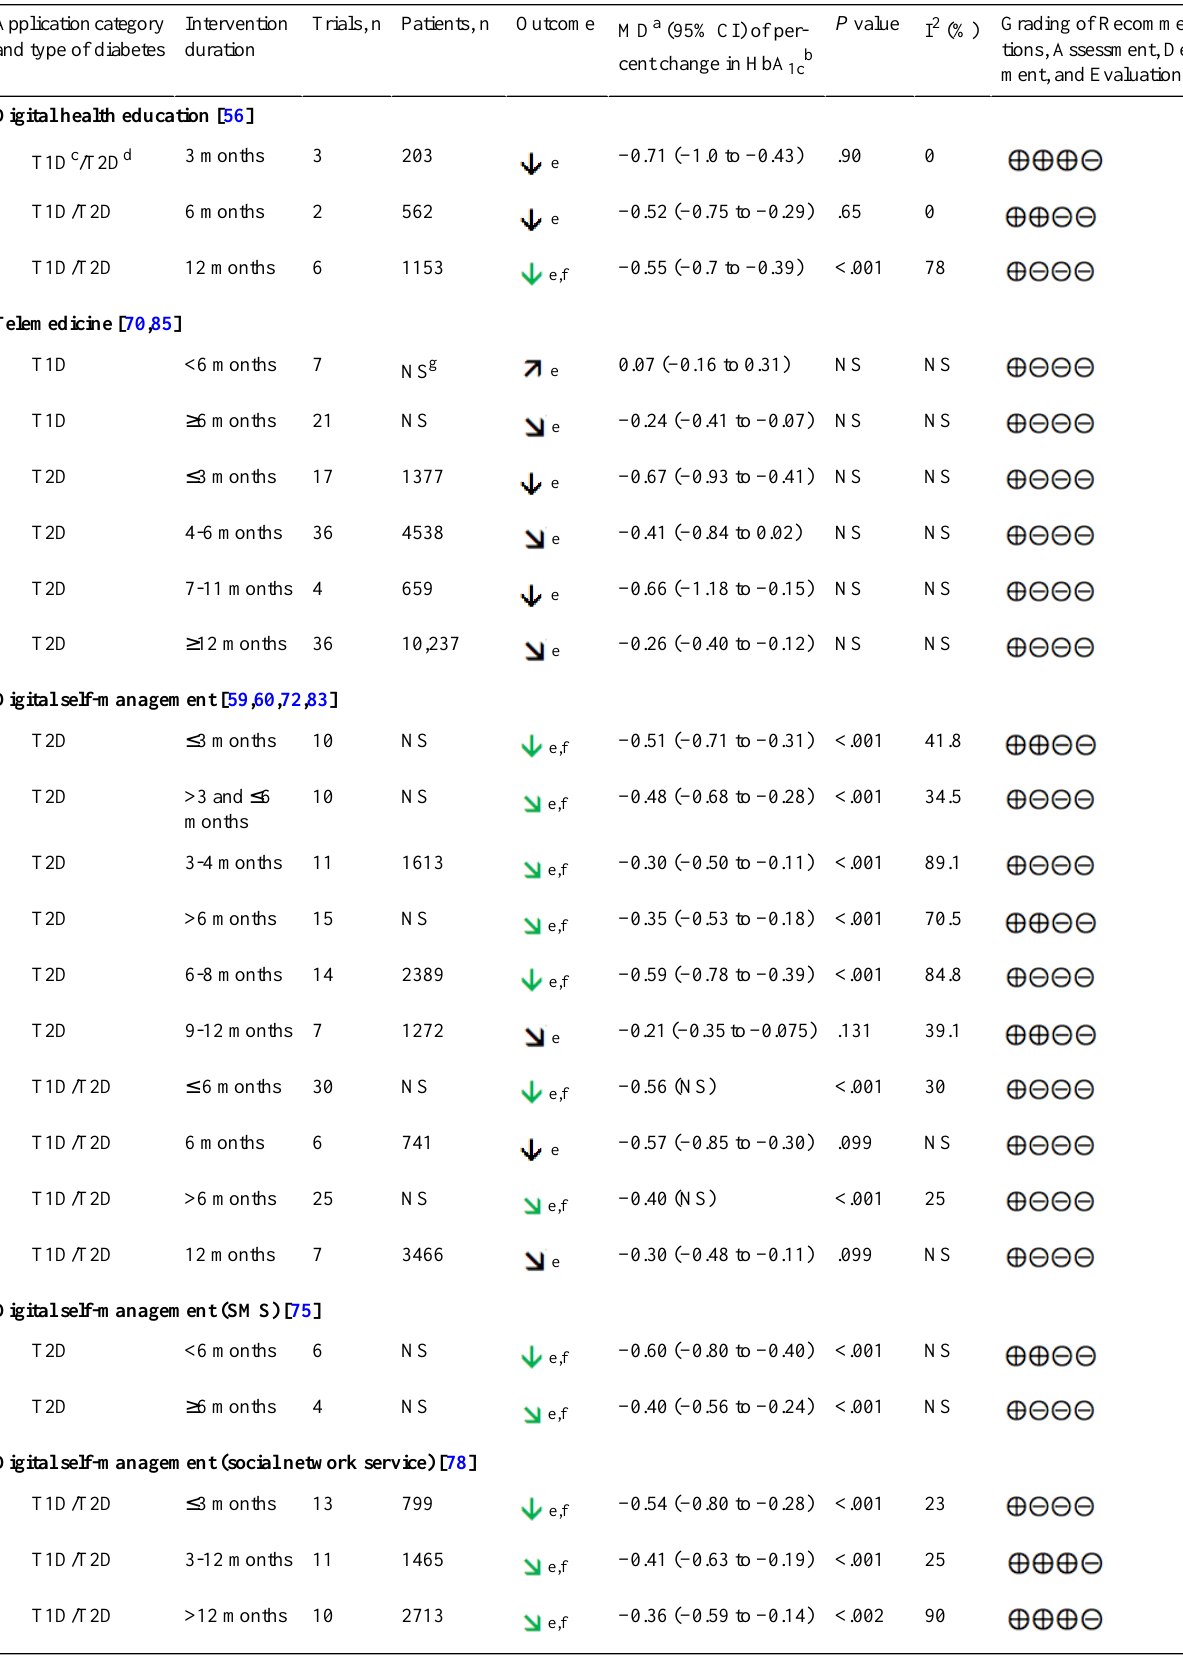
Table 3. Effectiveness of telemedicine on glycated hemoglobin in patients with diabetes, according to intervention duration.